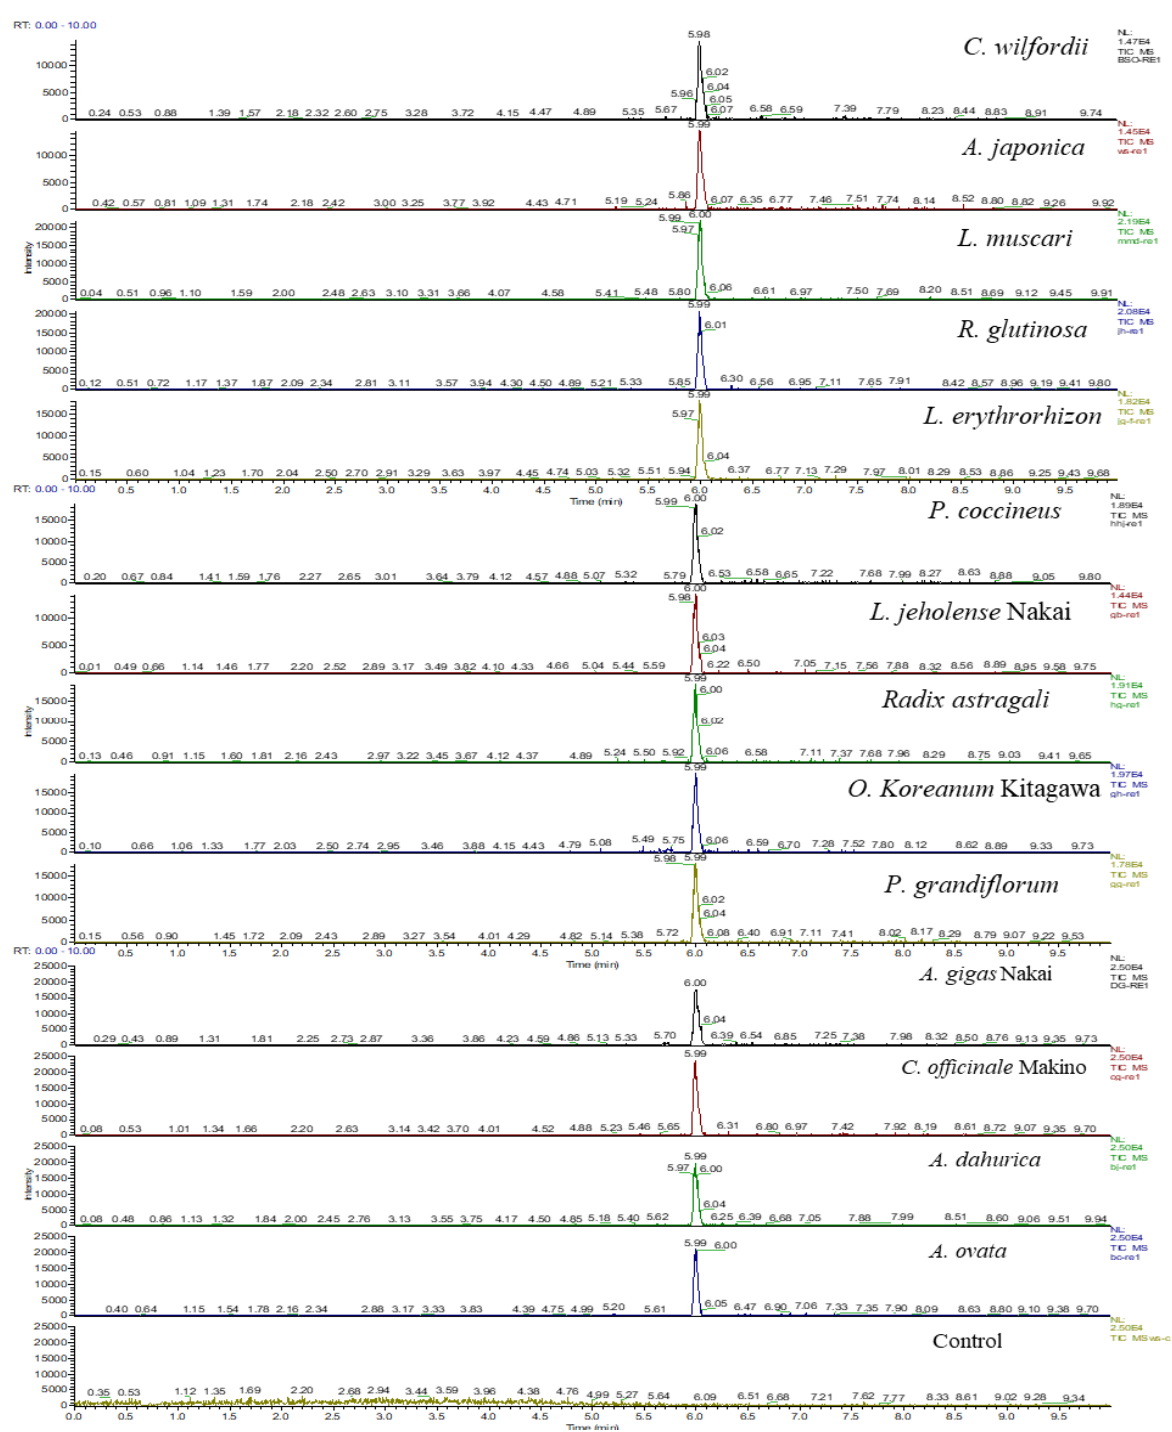
Figure 1. LC–MS/SM chromatogram of indoxacarb in fourteen medicinal herbs. Table 3. Recovery (%) of indoxacarb in 14 medicinal herbs analyzed by LC–MS/MS.